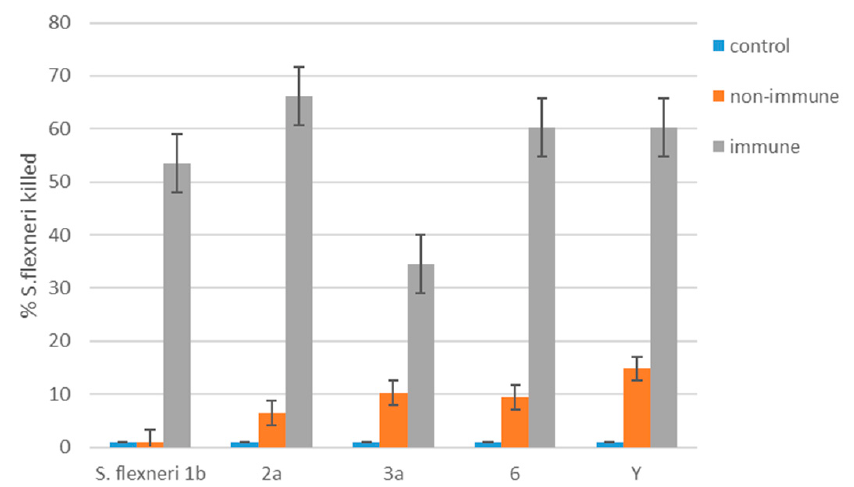
Figure 7. Serum bactericidal antibody assay on immune sera from mice immunized with PLVF at a dose of 125 µ g against virulent S. flexneri strains, serotypes 1b, 2a, 3a, 6, and Y. Wells containing S. flexneri bacteria with guinea pig complement with no serum were used as complement control. Non-immune wells contained sera from naïve mice. Data represent mean SBA rate for each serotype ± SEM.